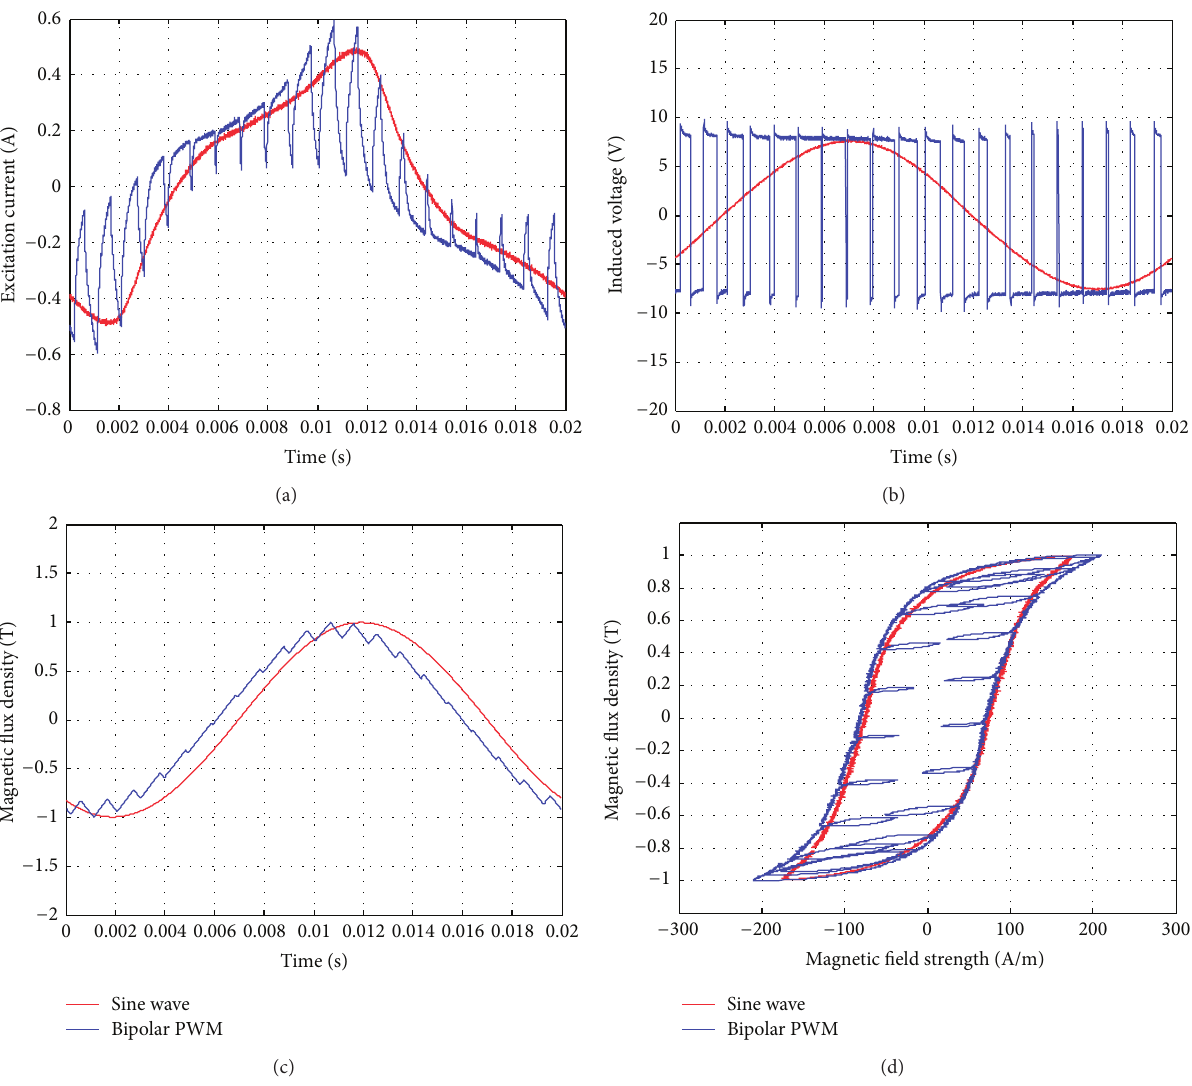
Figure 18: Parameters measured using the new toroidal frame for sinusoidal waveforms and unipolar PWM (with 𝐵 = 1T, 𝑓 = 50 Hz, 𝑚 𝑎 = 0.9, and 𝑚 𝑓 = 20): (a) excitation current, (b) induced voltage, (c) flux density, and (d) hysteresis curve.